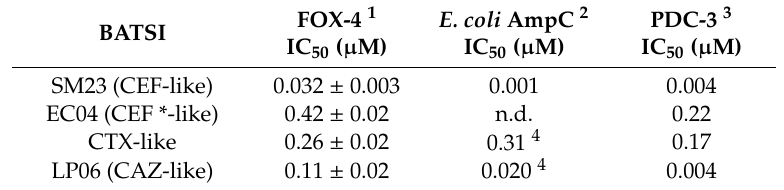
Table 3. IC 50 values for boronic acid transition-state analog inhibitor (BATSI)